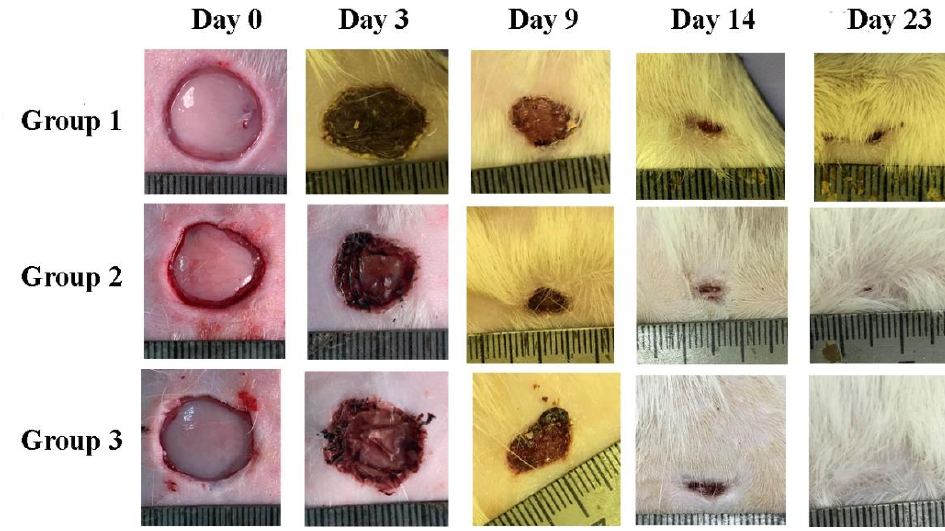
Figure 11. Images of wounds on days 0, 3, 9, 14, and 23 of the experiment. Group 1: control, group 2: SF, and group 3: SF-MP.